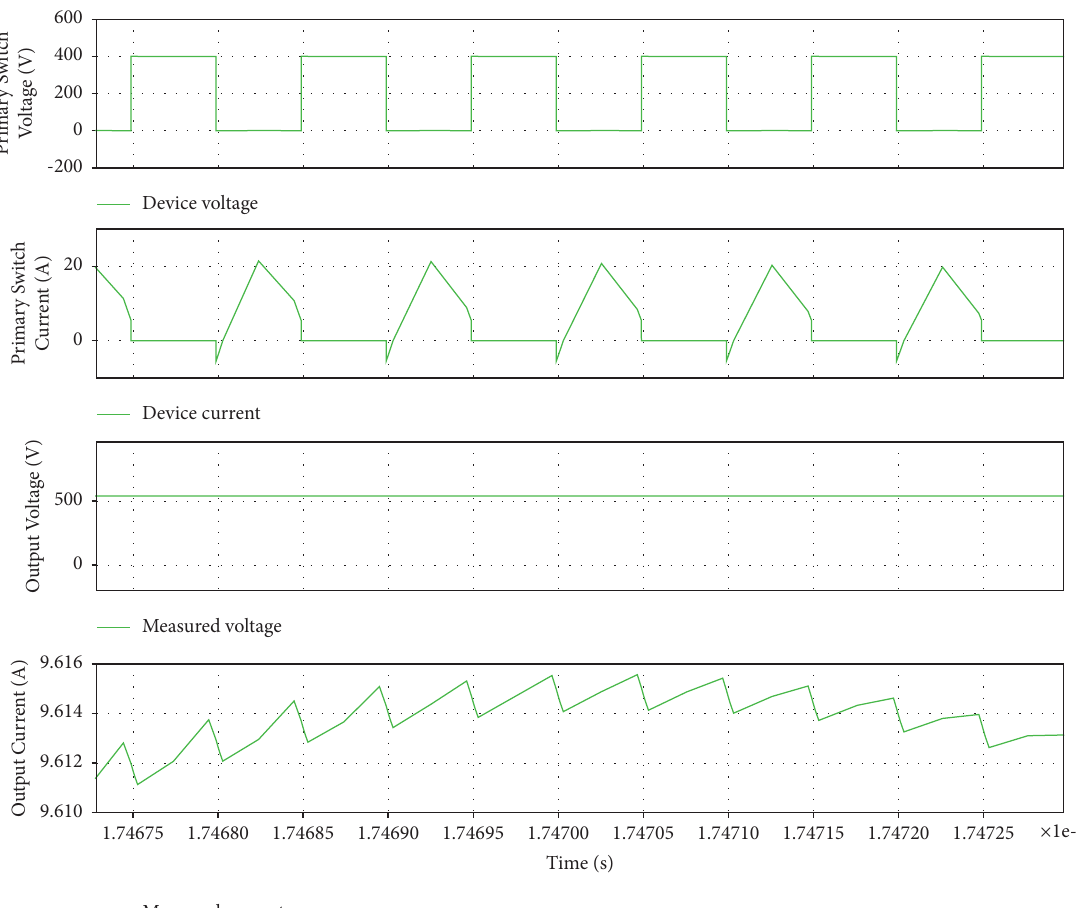
Figure 12: E-mode GaN HEMT enabled converter simulated